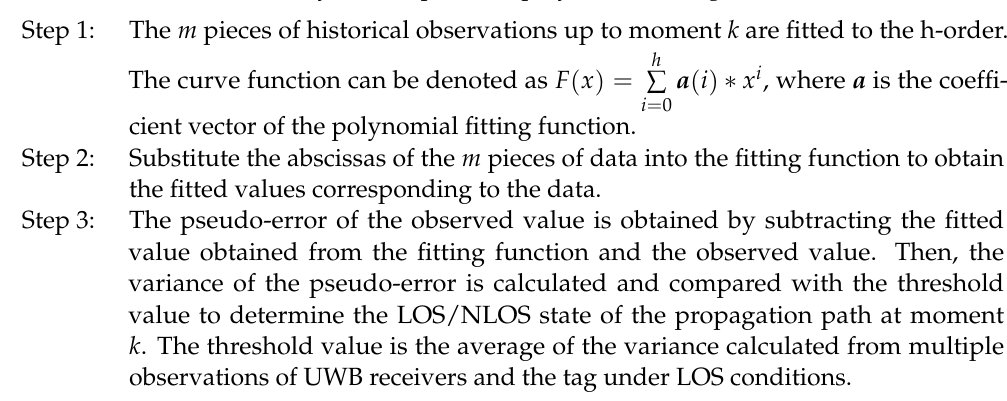
Figure 4. The sliding window identification scheme.